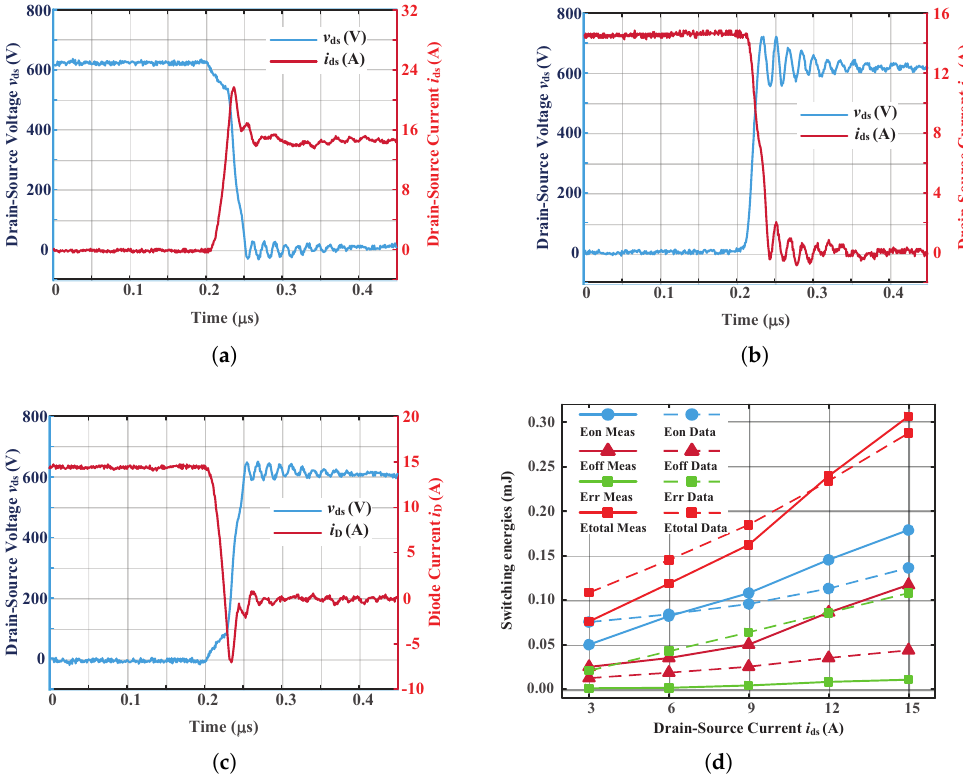
Figure 9. Switching characteristics of a phase-leg at v ds = 600 V and R g = 10 Ω ( a ) turn-on transient, ( b ) turn-off transient, ( c ) anti-parallel diode reverse recovery transient, and ( d ) relationship between the switching energy and load